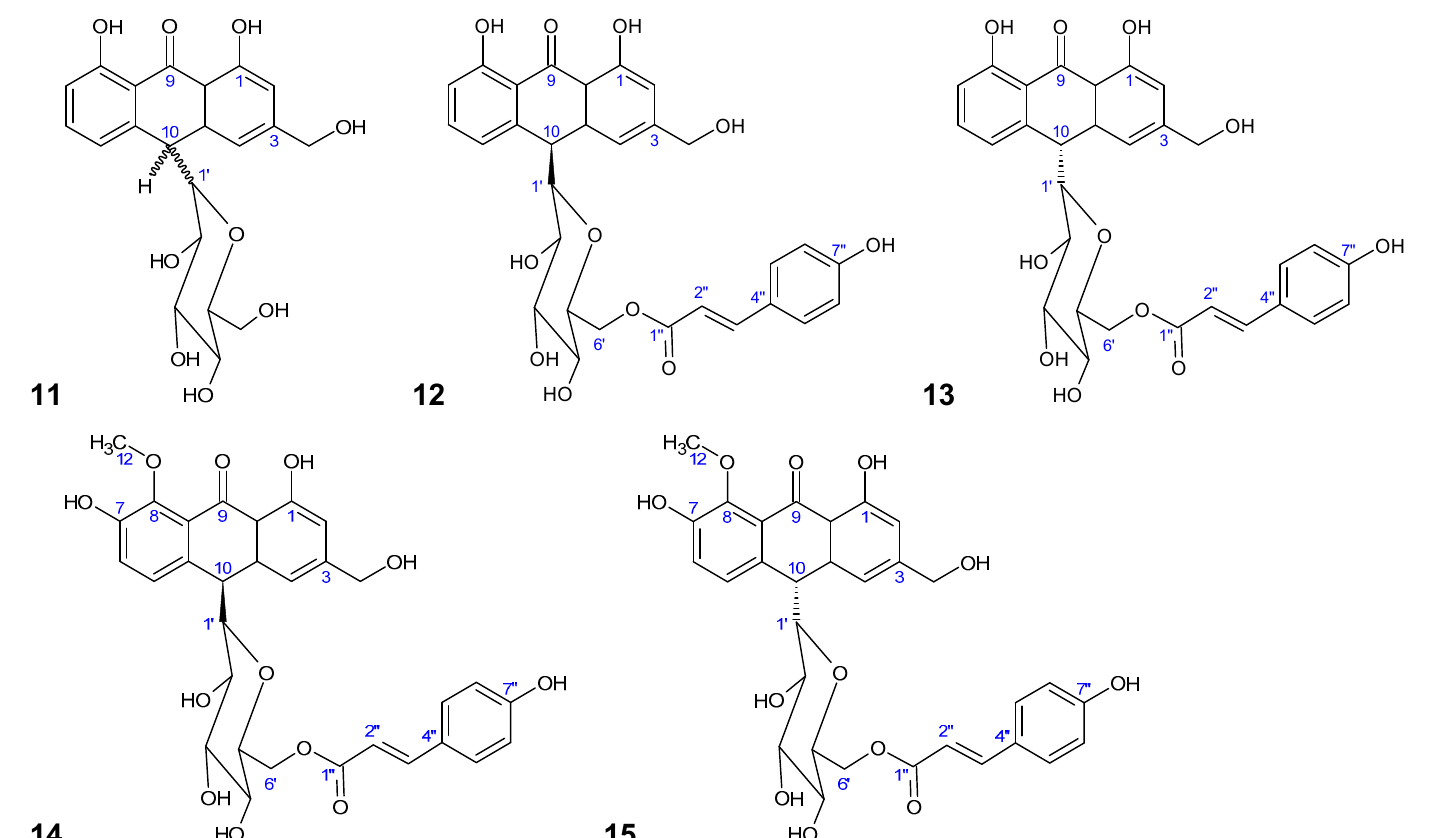
Figure 1. Chemical structures of isolated and tested phenolic polyketides from Aloe vera and A. plicatilis : 3 R -feralolide ( 1 ); 3 (cid:48) - O - β - D -glucopyranosyl-3 R -feralolide ( 2 ); 6- O - β - D -glucopyranosyl-3 R -feralolide ( 3 ); aloesin ( 4 ); 7- O -methyl-aloesin ( 5 ); 7- O -methyl-aloeresin A ( 6 ); aloeresin D ( 7 ); plicataloside ( 8 ); 5,6,7,8-tetrahydro-1- O - β - D -glucopyranosyl-3,6-dihydroxy-8-methylnaphthalene ( 9 ); aloeemodin ( 10 ); aloins A/B ( 11 ); 6 (cid:48) - O -( E )-coumaroylaloin A ( 12 ); 6 (cid:48) - O -( E )-coumaroylaloin B ( 13 ); 6 (cid:48) - O -( E )-coumaroyl-7-hydroxy-8- O -methyl-aloin A ( 14 ); 6 (cid:48) - O -( E )-coumaroyl-7-hydroxy-8- O -methyl-aloin B ( 15